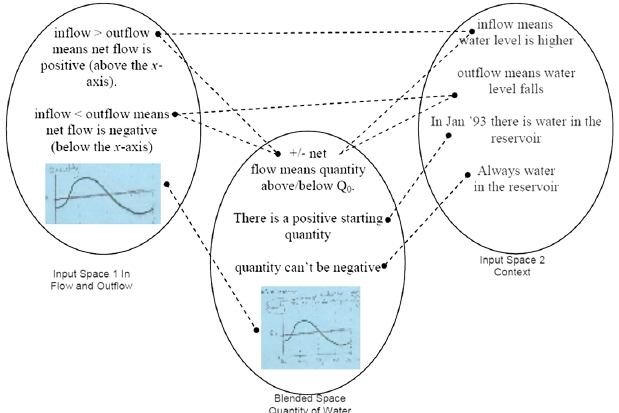
FIG. 5. Blending diagram from the work of Gerson and Walter